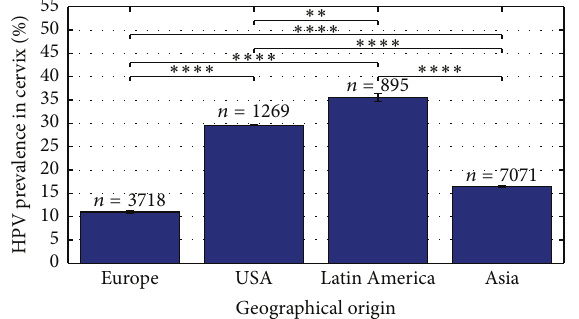
Figure 4: HPV prevalence in normal pregnancies depends on geo- graphical location. HPV prevalence in cervix of normal pregnancies in %. 32 studies have been included in the present analysis, 𝑁 Europe = = 4 , 𝑁 = 5 , and 𝑁 = 10 . 𝑁 indicated 13 , 𝑁 USA Latin America Asia number of studies included. 𝑛 indicates number of cases included. ∗∗ 𝑃 < 0.01 , ∗∗∗∗ 𝑃 < 0.0001